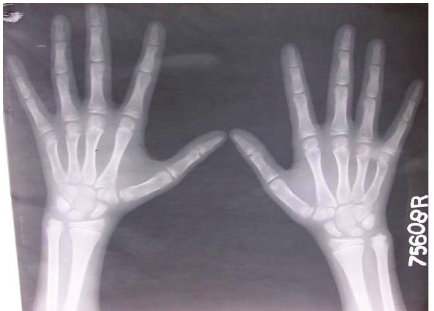
Figure 4: Hand-wrist radiograph for growth-spurt